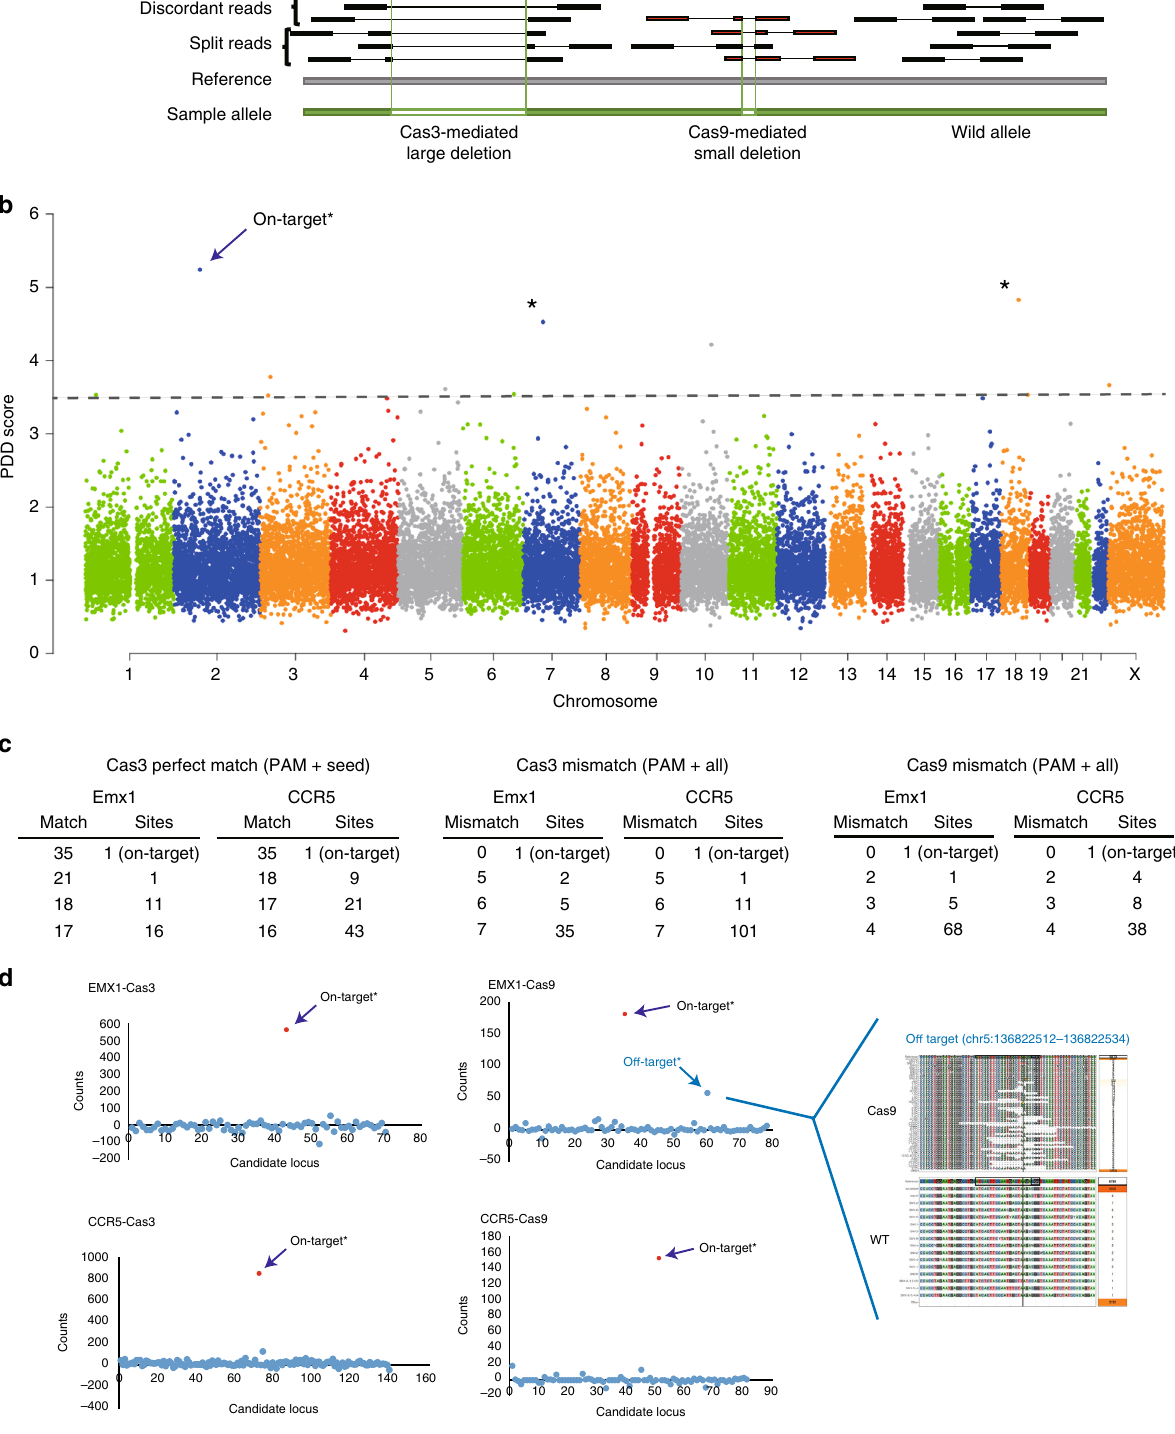
Fig. 3 Off-target analysis of the CRISPR-Cas3 system. a Schematic of discordant read pairs and splitting reads by paired-end NGS. Cas3-mediated large mutations were detected by discordant and split read analyses, but Cas9-mediated small mutations were only detected by splitting read analysis. b WGS of 293T cells mediated by the CRISPR-Cas3 system targeting EMX1 on chromosome 2. * P < 0.05, Repetitive Grubbs test. c POT sites detected by GGGenome searches. Number of consecutive perfect matches or 32-nt partial matches fl anking PAM sequences (AAG, TAG, AAC, GAG, AGG, and ATG) are shown. Every sixth position from the 5 ′ end of the PAM sequences was regarded as a match. d Microarray-based capture sequencing for POT sites selected by GGGenome in c . An off-target site of Cas9 targeting the EMX1 loci showed a high score and a variety of indel mutations. Source data are in the Source Data fi